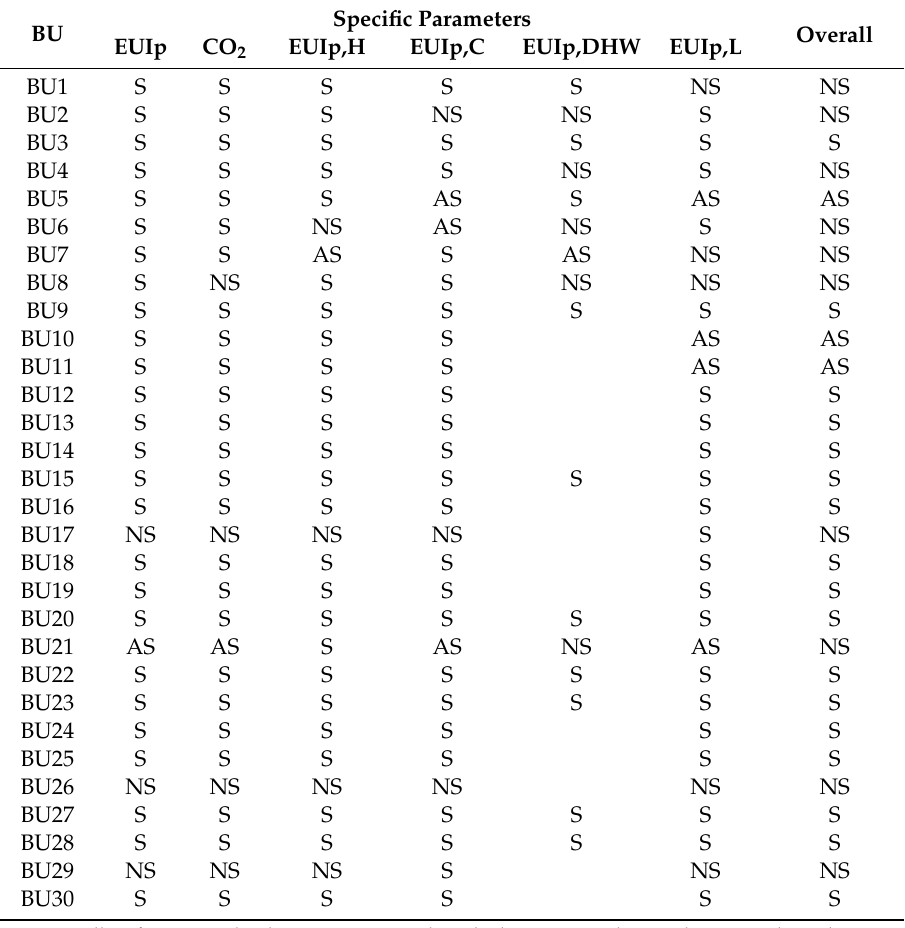
Table 10. Stabilization status for all building